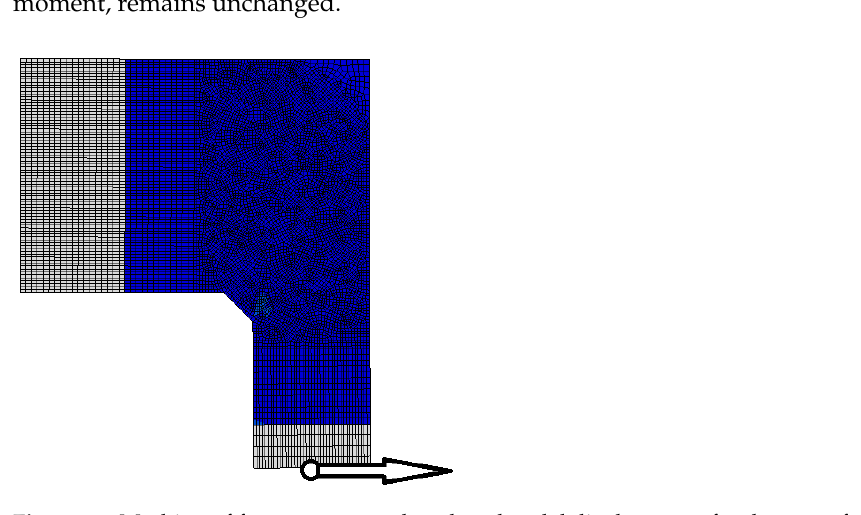
Figure 23. Meshing of frame corner and analyzed nodal displacement for the case of elements with different cross section heights.